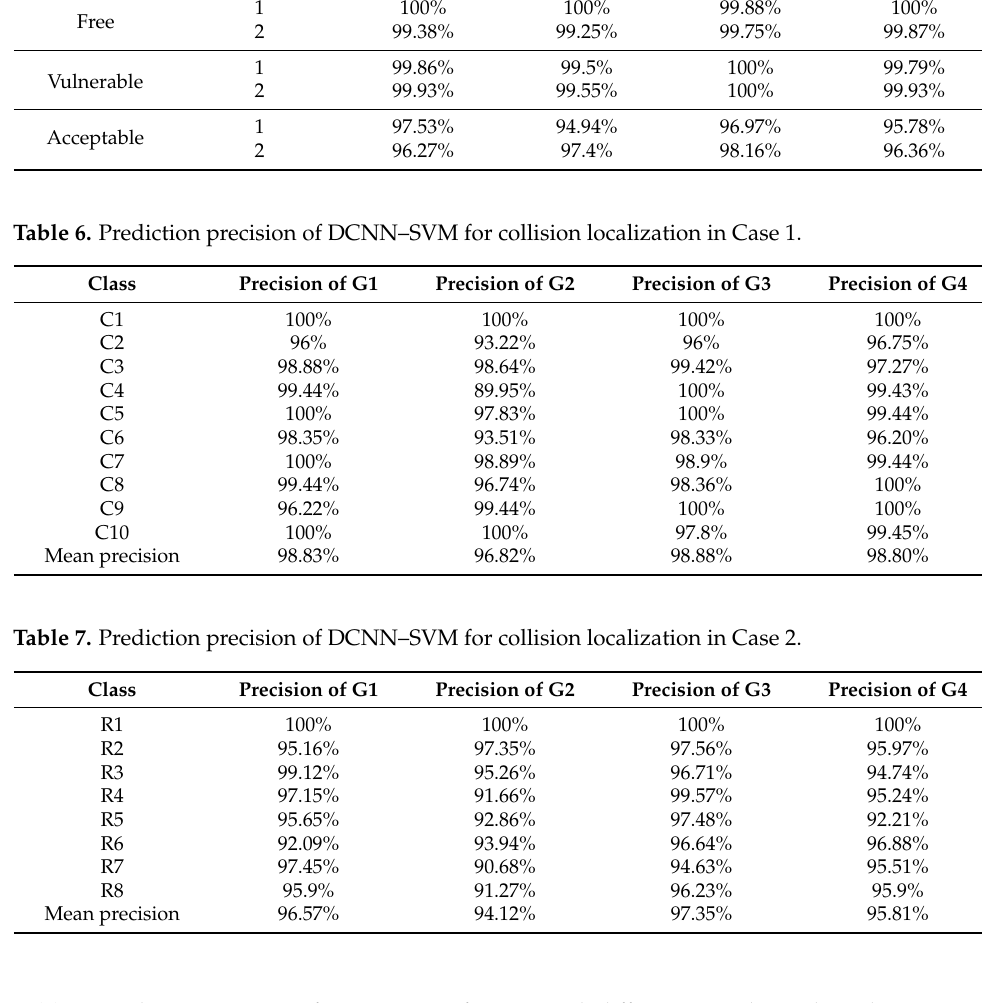
Table 8. Prediction accuracy of DCNN–SVM for CLC with different convolution kernels in Case 1.